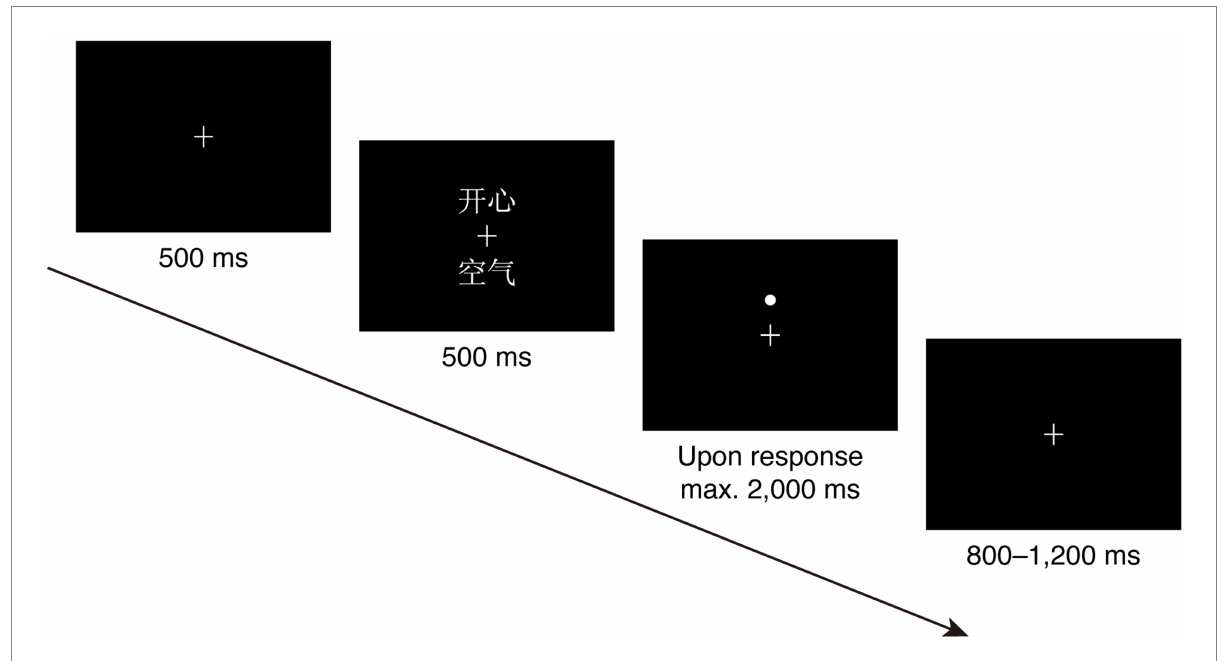
FIGURE 1 An overview of a trial in the dot-probe